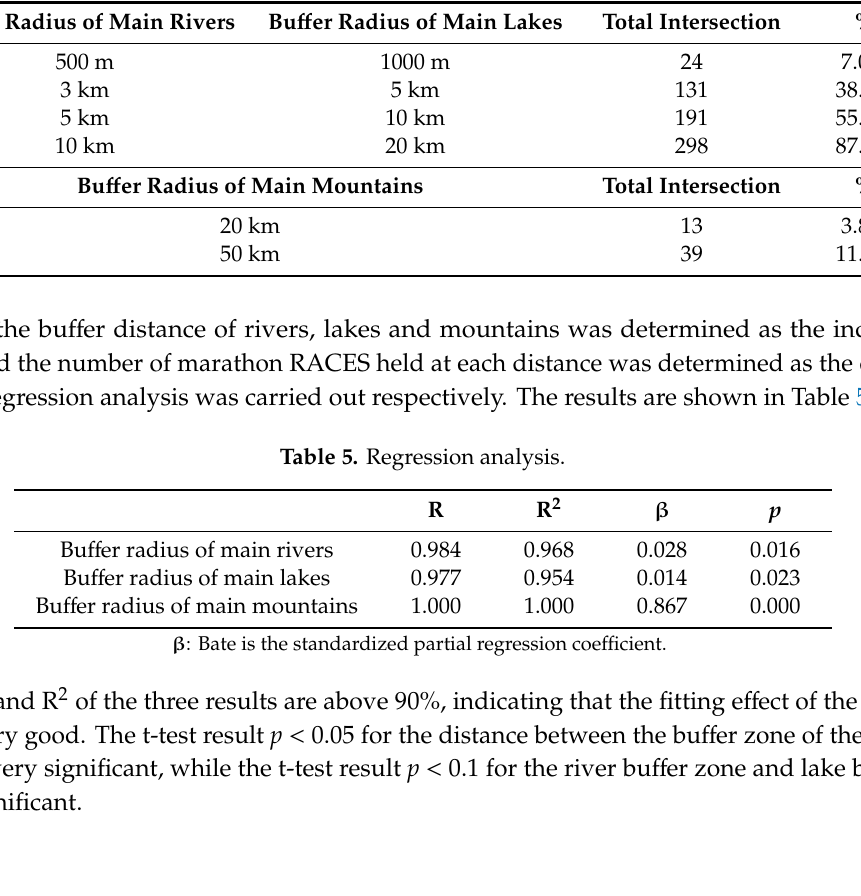
Figure 6. Mountain ranges and marathon running coupling diagram. Table 4. Intersect output of the bu ff er radius of water resources / mountains and marathon running.